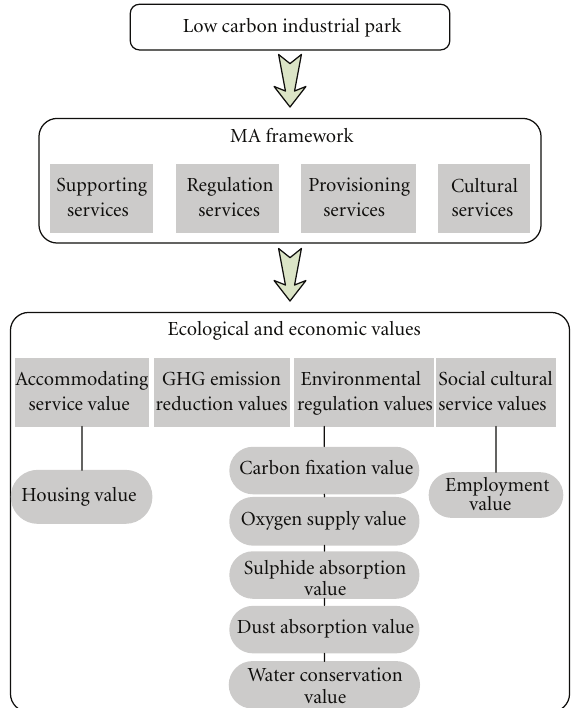
Figure 1: Ecological and economic value assessment framework of the low-carbon industrial